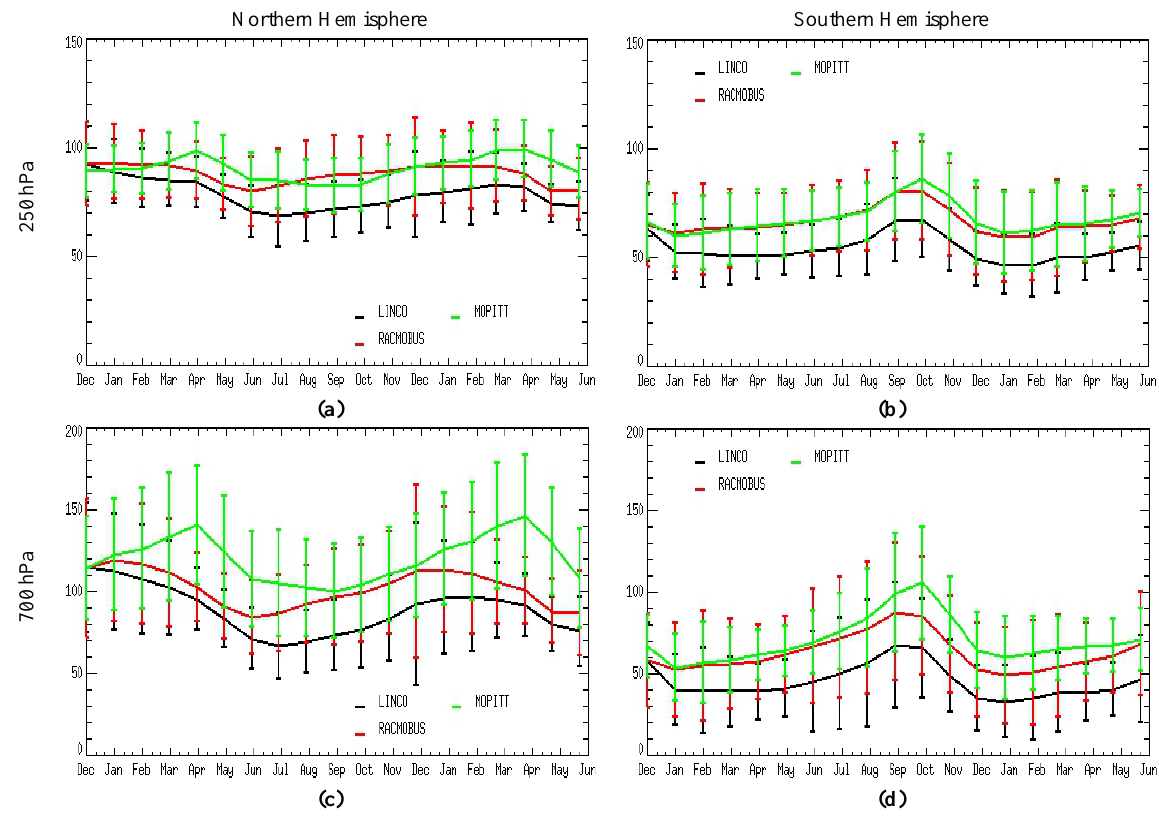
Fig. 4. CO fields in parts per billion by volume (ppbv) calculated by LINCO (black lines) and by RACMOBUS (red lines) and retrieved from MOPITT measurements (green lines) for NH (a) (left) and SH (b) (right) at 250hPa (upper panel) and at 700hPa (c) and (d) (lower panel). Note that modeled CO fields have been smoothed by MOPITT averaging